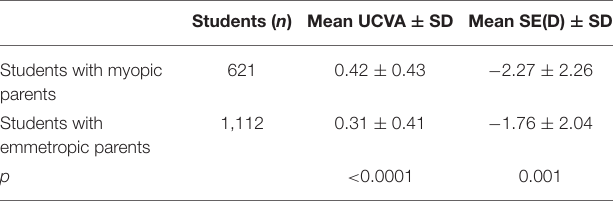
TABLE 3 | The mean uncorrected visual acuity and spherical equivalent refraction with different digital devices used for online classes during home confinement period.